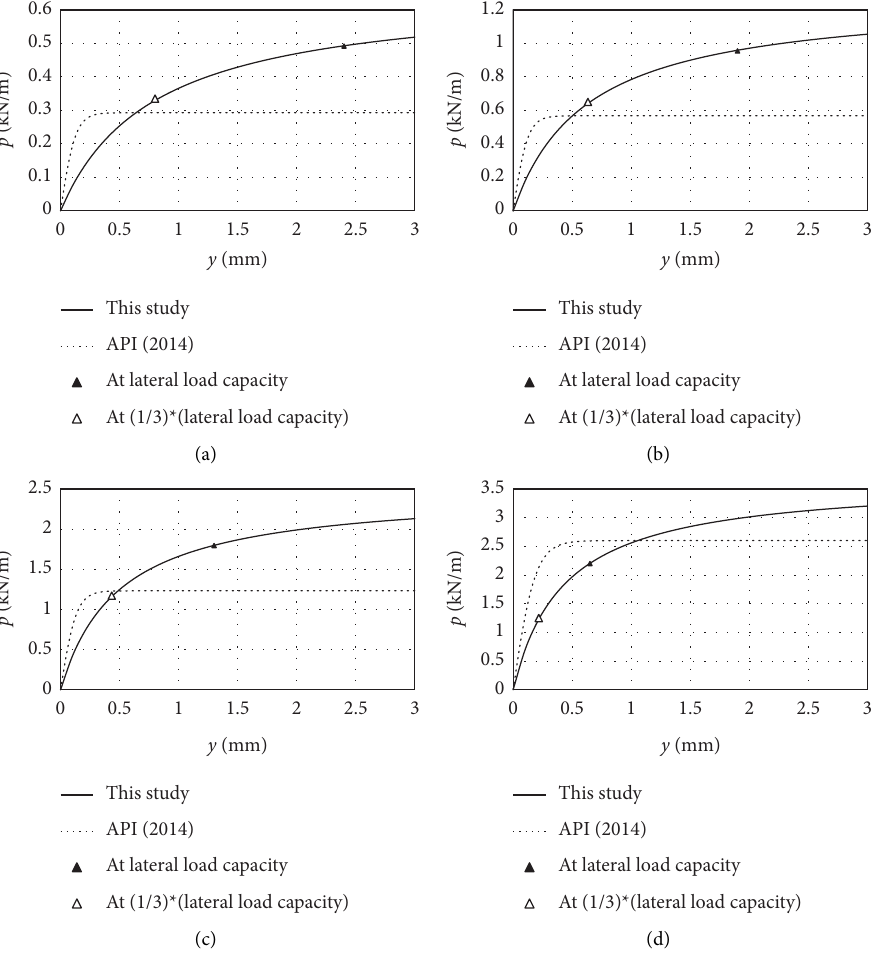
Figure 7: Comparison between experimental static p - y curves and API p - y curves (relative density of 90%): (a) 1 D , (b) 2 D , (c) 4 D , and (d) 6 D